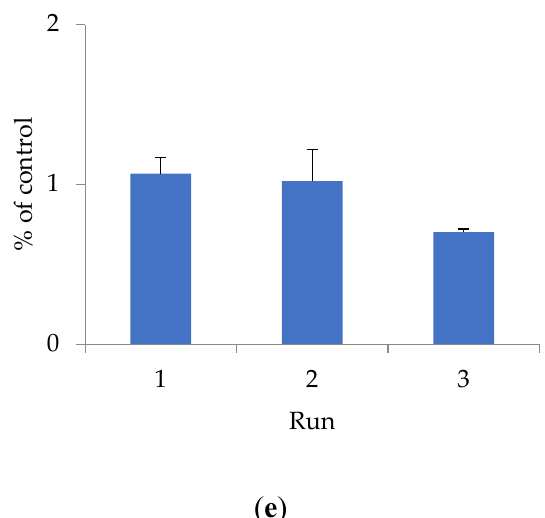
Figure 1. The effect of shungite on the HEK293 cell line, assessed by the Alamar Blue method: ( a ) Sh5; ( b ) Sh20; ( c ) ShT20; ( d ) Sh209; ( e ) ShT209. Data presented as a mean ± SD ( n = 3).